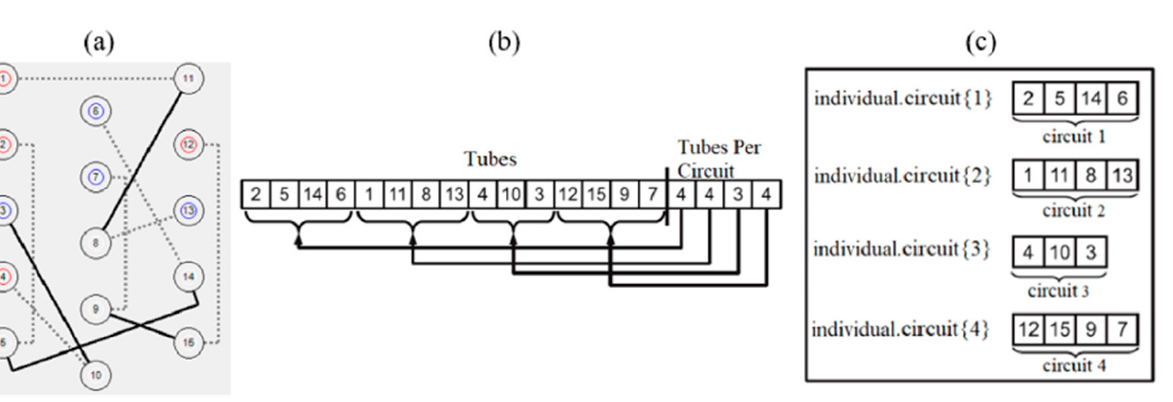
Figure 22. Scheme of circuitry layout: ( a ) 15-tube HX; ( b ) two-part chromosome; ( c ) split circuit chromosome [106].